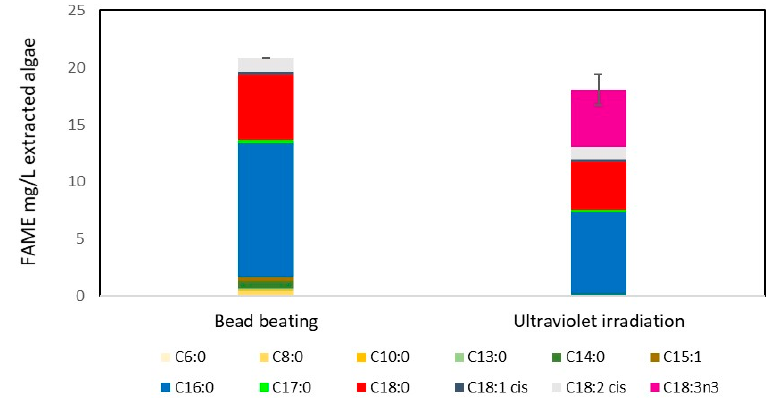
Figure 5. Comparison of biodiesel yield from disruption methods of nitrate rich C. reinhardtii culture. Fatty acid methyl ester yields from both bead beating and ultraviolet light irradiation disruption is shown. Yields represent transesterified lipids from 1 L of culture. UVB intensity at 1.5 W/cm 2 for 300 s (equivalent to 450 J/cm 2 UVB). Irradiation and bead beating carried out as in Materials and Methods. n = 1 for bead beading, n = 2 for UV irradiated samples. Error bars represent the range. The legend indicates different FAME chain lengths.